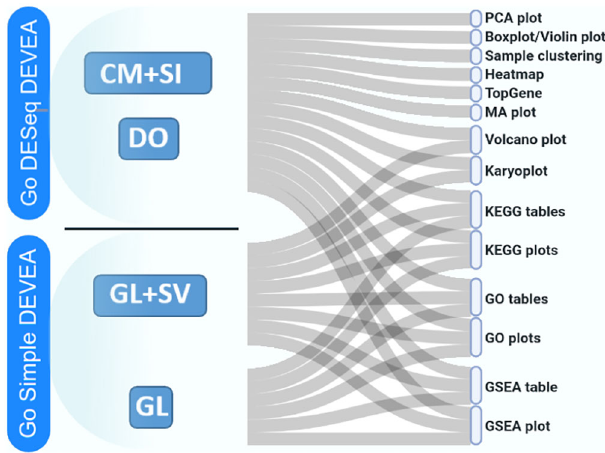
Figure 6. Possible types of graphical representations in DEVEA depending on data input